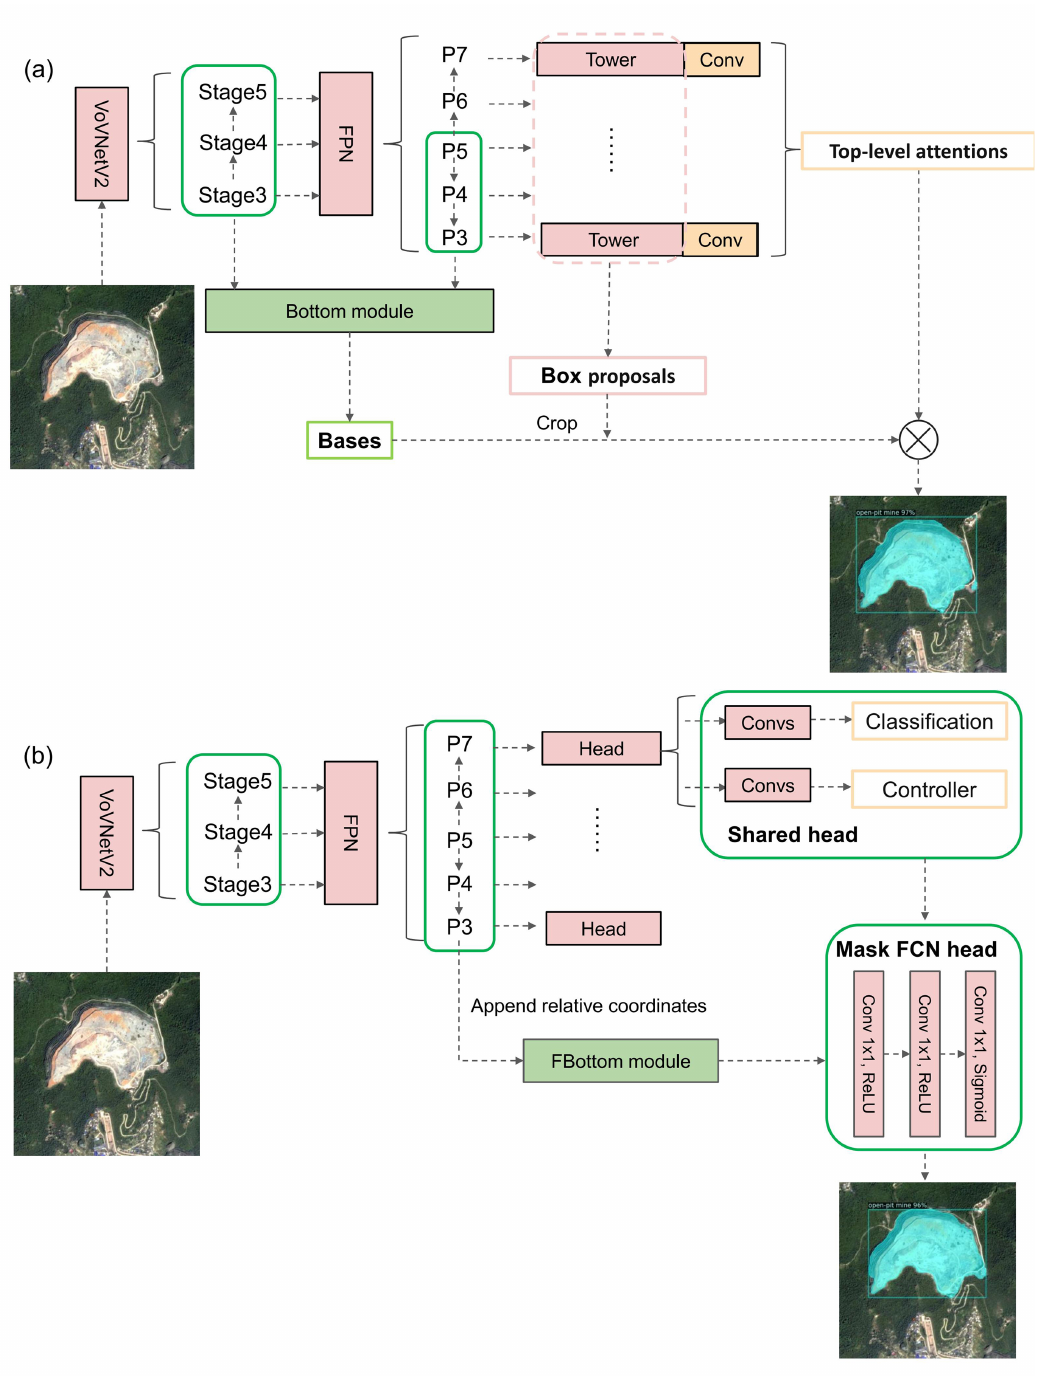
Figure 4. Structure of BlendMask-VoV and CondInst-VoV. ( a ) Structure of BlendMask-VoV; ( b ) struc- ture of